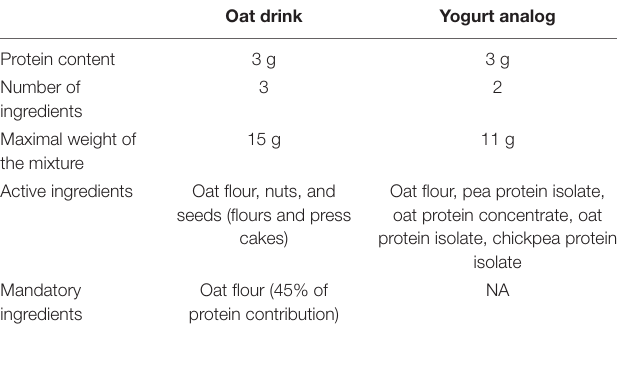
TABLE 3 | Constraints to optimize two commercial products.